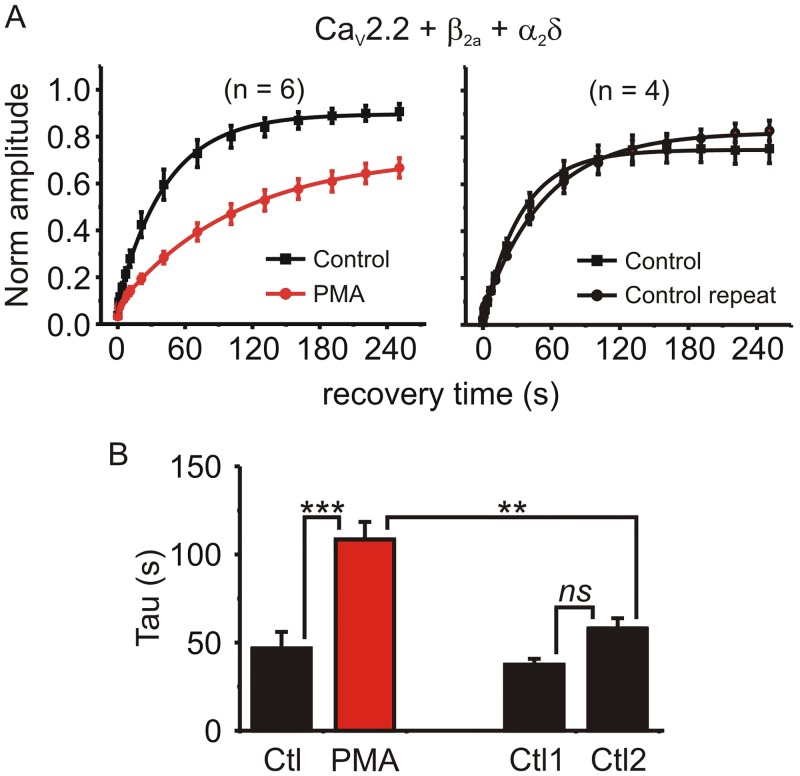
PMA significantly prolonged recovery from inactivation in β2a containing channels.
(A) HEK293 cells were transfected with CaV2.2, α2δ, and β2a subunits. Inactivation was produced by a 10s prepulse and recovery tracked as in Fig 1F. This was done twice in each cell: in some cells PMA was applied 5-min before the second stimulation protocol (left panel), while other cells were used as time-matched controls (i.e. no PMA was applied; right panel). Solid lines show exponential fits to the mean data (left panel: control A = 0.82, t = 40.4 s; PMA A = 0.65, t = 101 s, comparison of fits F = 24.2 p < 0.0001: right panel control A = 0.74, t = 36.9 s; control repeat A = 0.78, t = 55.8 s, comparison of fits F = 2.28 p = 0.1). (B) The time constant of the exponential fit to each individual cell was calculated and the means plotted. PMA significantly prolonged recovery from inactivation (* p < 0.05, ** p < 0.01, ns = “not significant” using ANOVA followed by Bonferroni’s multiple comparison test).